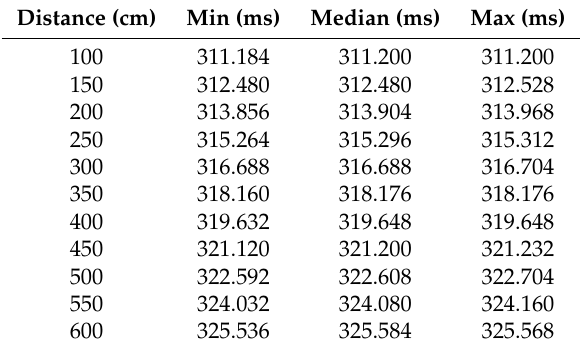
Table 3. Measured end-to-end round trip